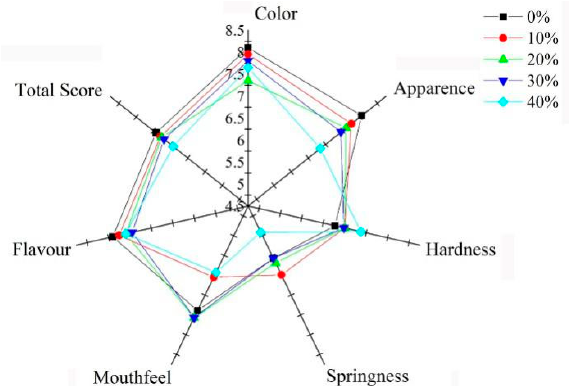
Figure 3. Changes in wheat flour noodles sensory evaluation as a function of Chinese yam powder. The digital number present the final result in ten-point system. Each coordinate axis has the same scale.